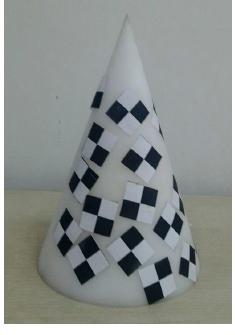
Figure 8. The measured cone.